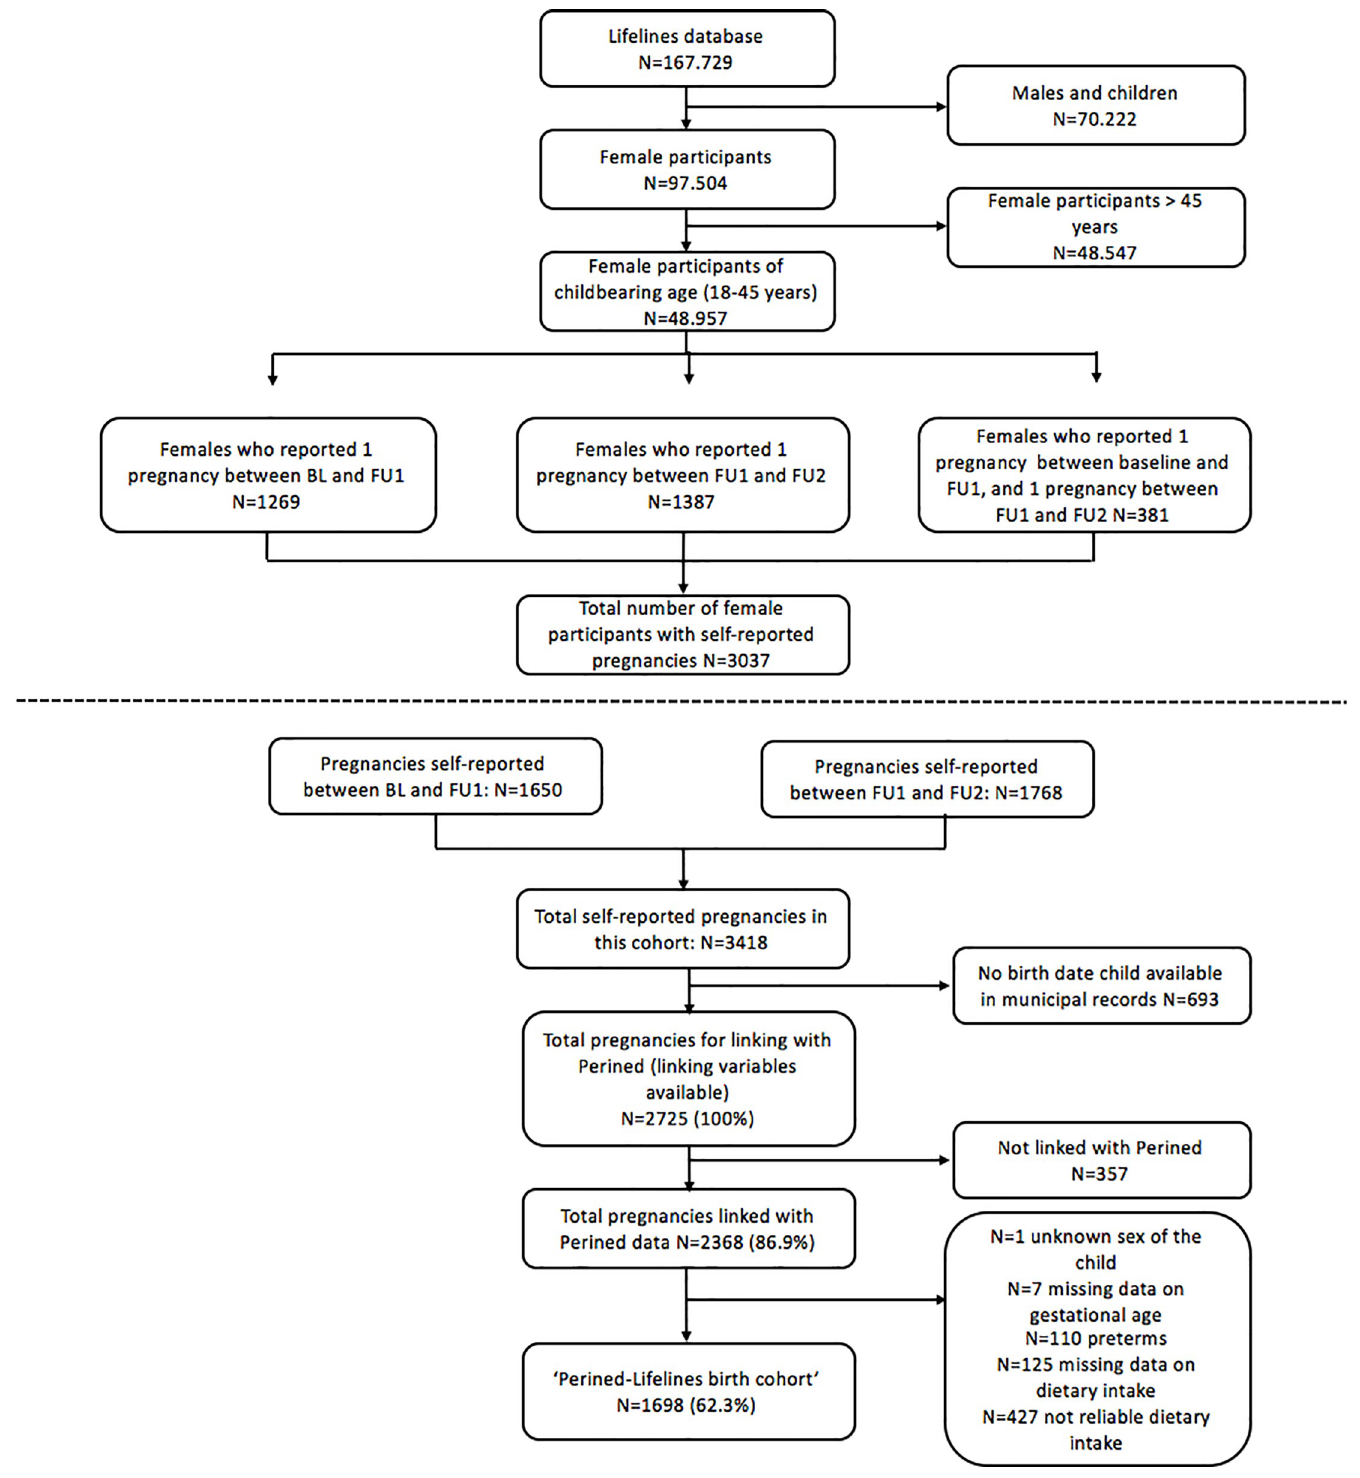
Fig 2. Flow chart of the Perined-Lifelines linked birth cohort.